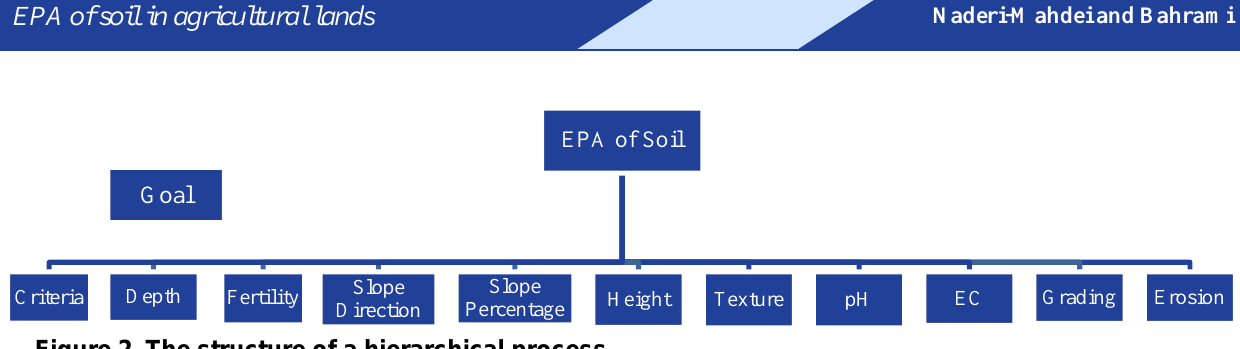
Figure 2. The structure of a hierarchical process